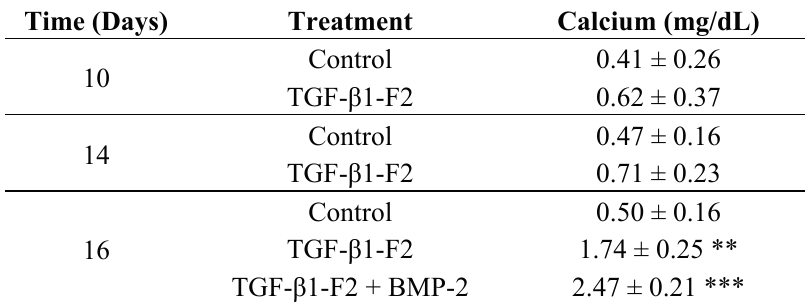
Table 1. Quantification of calcium content as indication of